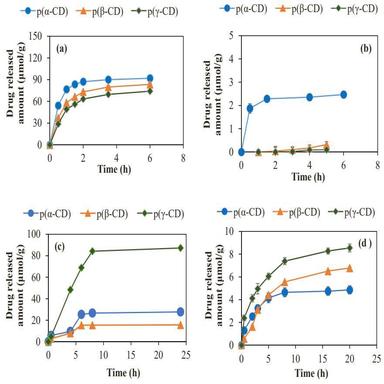
(a) Bisphenol A (BPA) and (b) Curcumin (CUR) release profiles of p(α-CD), p(β-CD), and p(γ-CD) particles in ethanol solution. (c) Bisphenol A and (d) Curcumin release profiles of p(α-CD), p(β-CD), and p(γ-CD) particles in PBS.